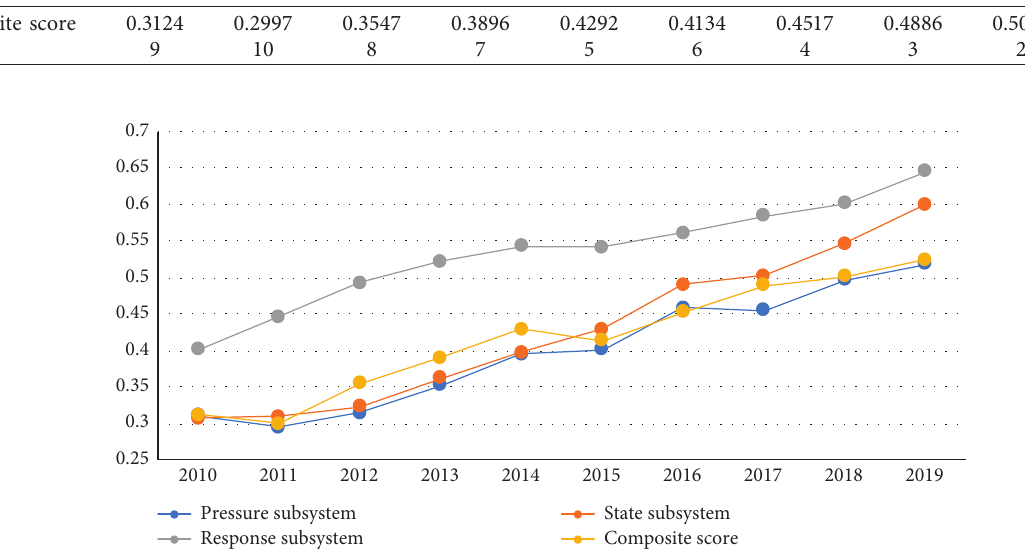
Figure 1: The scores of each subsystem and the composite scores of the YREB WECD